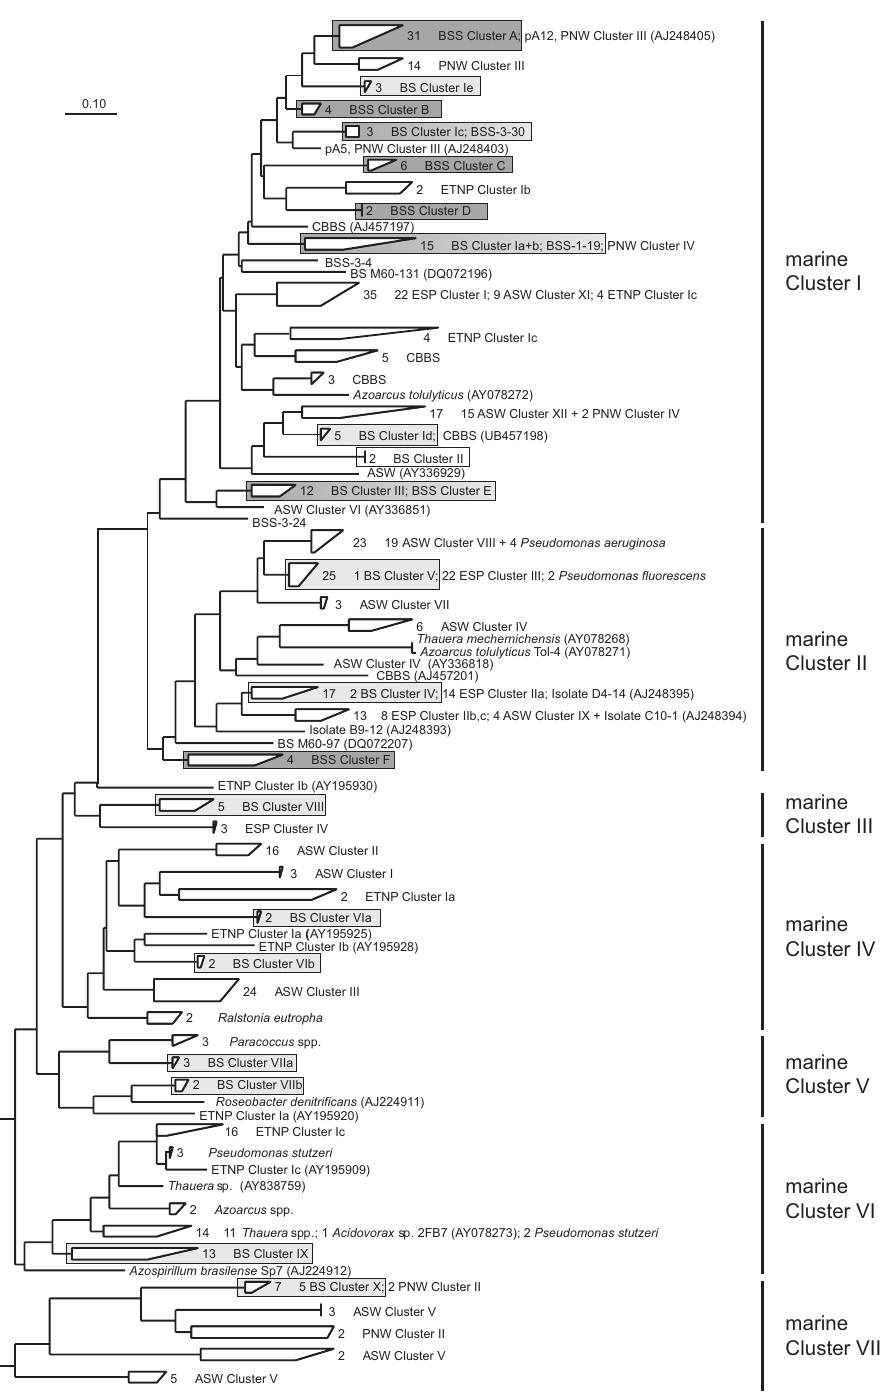
Fig. 4. Phylogenetic tree of nirS sequences from all marine habitats. Tree was calculated by the neighbour joining method based on an alignment of 166 amino acids. Roman numbers indicate marine nirS sequence clusters. nirS sequences from sediment samples from the Baltic Sea were labelled with BSS. Clones were labelled with numbers to indicate from which depth of the sediment sequences were retrieved (1, 0 to 5mm; 2, 5 to 12mm; 3, 12 to 30mm) and a second number for the respective clone. nirS clusters from Baltic Sea sediments were labelled with A to F. The number after the polygon indicates the number of clones of a given cluster. ASW, Arabian Sea water column; BS, Baltic Sea water column; CBBS, cyanobacterial bloom Baltic Sea; ESP, eastern South Pacific sediment; ETNP, eastern tropical North Pacific sediment; PNW, Pacific Northwest